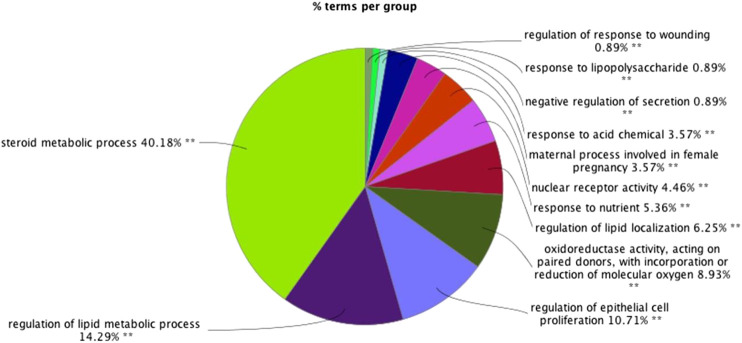
The results of gene ontology (GO) functional analyses: (A) histogram; (B) pie chart.∗∗p < 0.01*p < 0.05.